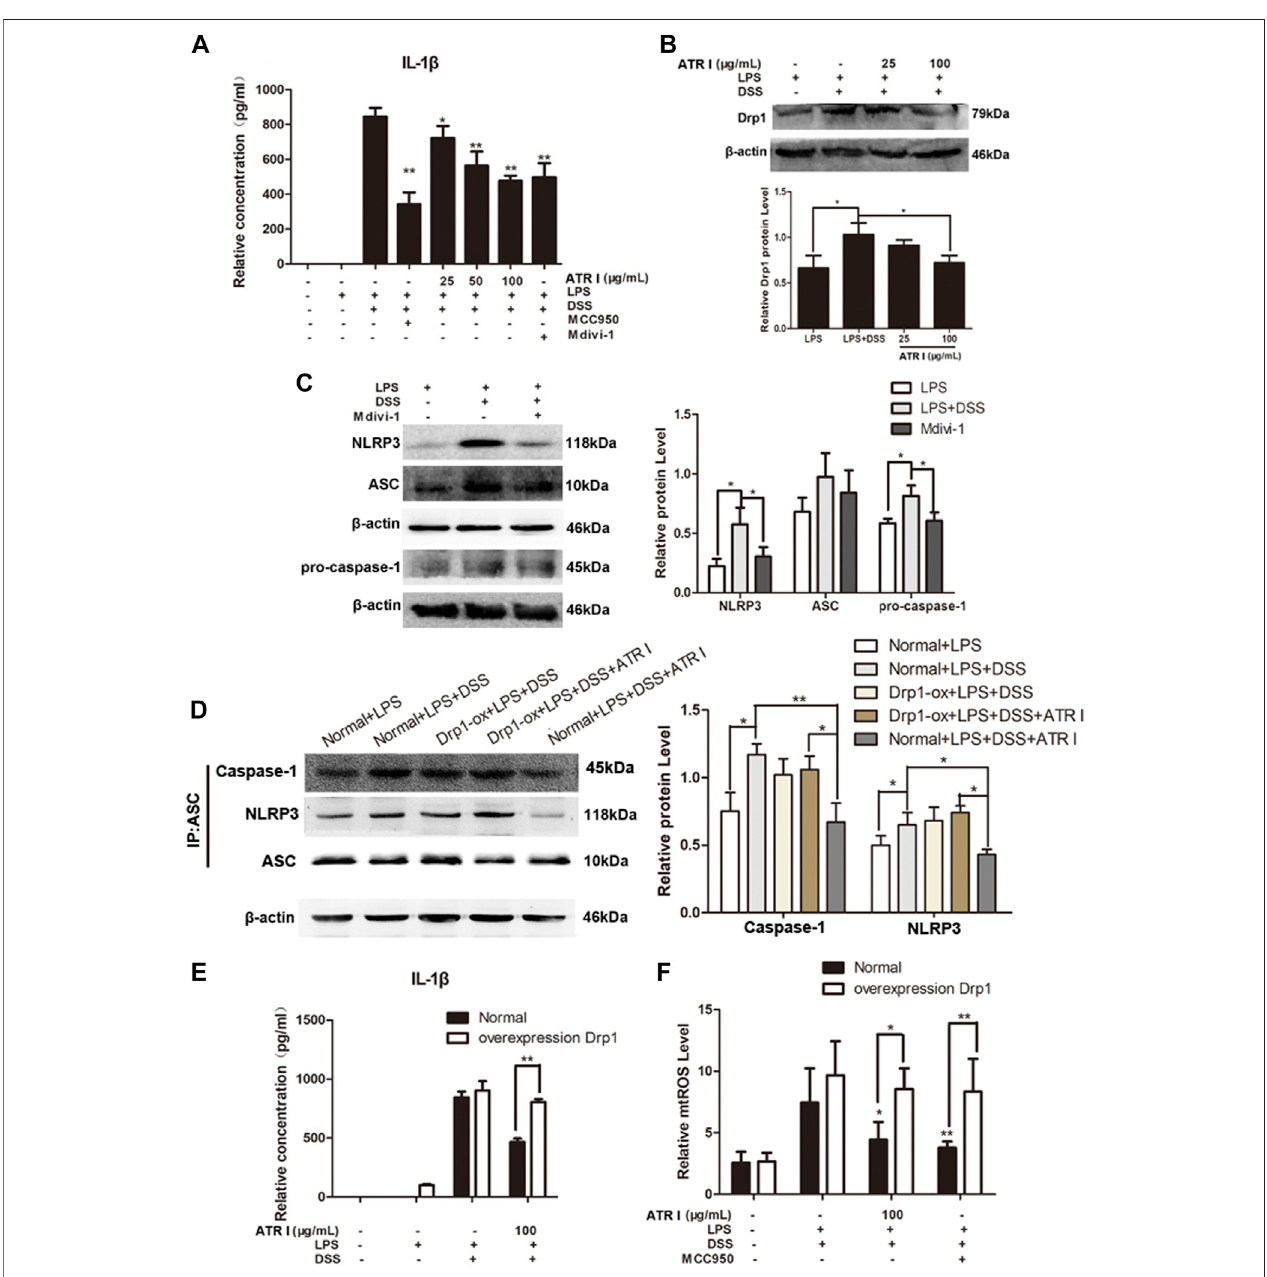
FIGURE7| AtractylenolideIinhibitedNLRP3in fl ammasomeactivationbyaDrp1-dependentmannerinLPS/DSS-stimulatedmiceBMDMs.Togeneratemacrophages with the overexpression ofDrp1, Drp1 lentivirus expression vector transduction and empty vector transduction were used to infect BMDMs. Mice BMDMs were pretreated withPBSoratractylenolideIfor2 handthenstimulatedwith5%DSSandLPS(100 ng/ml)forindicatedtimeperiods. (A) TheexpressionofIL-1 β intheculturesupernatants was measured by ELISA. (B) The expression levels of Drp1 were detected by the Western blot analysis (n (cid:2) 3 per group). (C) Expression levels of NLRP3, ASC, and pro – caspase-1in BMDMstreated withMdivi-1 weredetectedbythe Western blotanalysis. (n (cid:2) 3 per group). The densitometric analysis bar diagram ofthe results. (D) Cell lysates were immunoprecipitated with anti-ASC. The NLRP3 and caspase-1 expression were detected by the Western blot analysis. (E) Overexpressing Drp1 expression counteracted the restraint of atractylenolide I on the release of IL-1 β of LPS/DSS-stimulated BMDMs. (F) Cells were stained with MitoSOX and then analyzed by fl ow cytometry (n (cid:2) 3 per group). The densitometric analysis bar diagram of the results: * p < 0.05, ** p < 0.01 vs. Normal + LPS + DSS + ATR I (mean ± S.D).